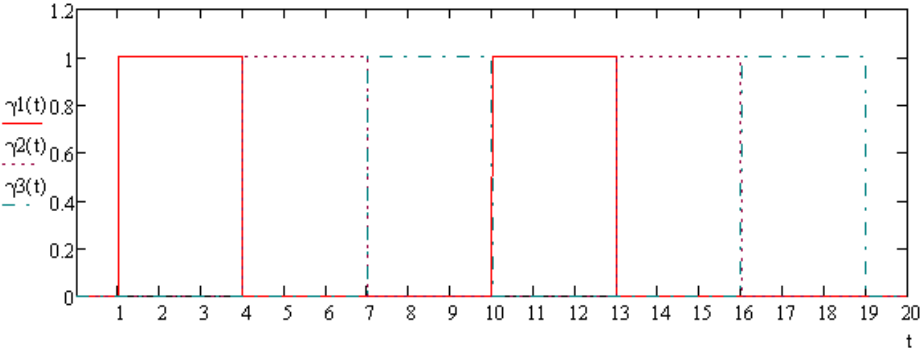
Figure 3. Initial observation plan.